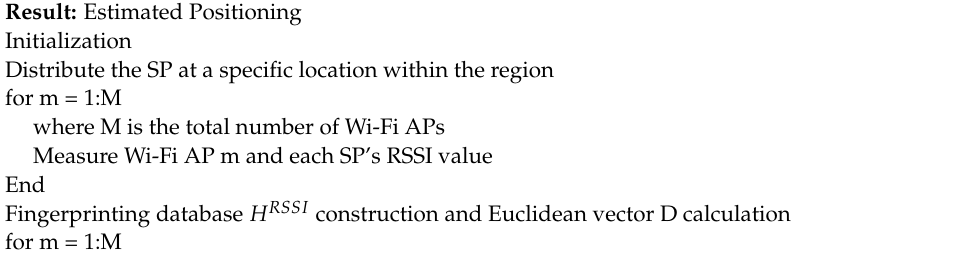
Algorithm 1: Proposed Indoor Positioning Algorithm Result: Estimated Positioning